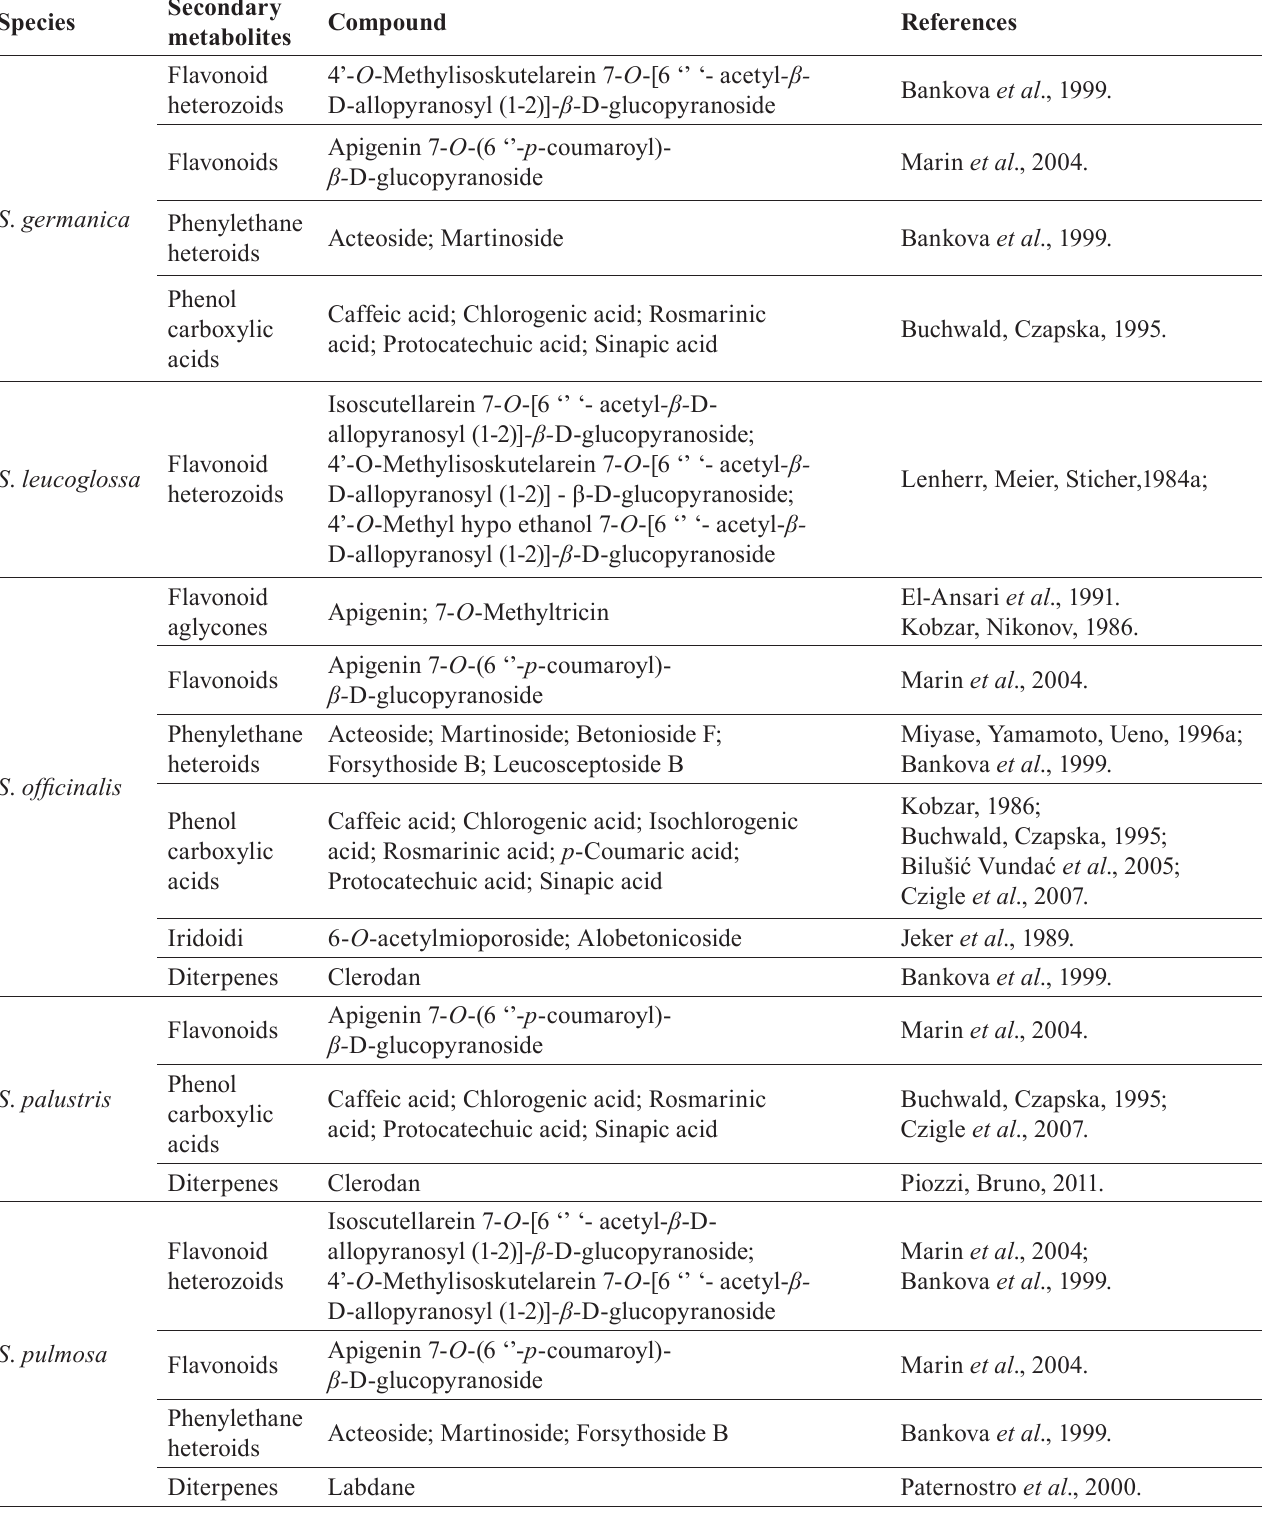
TABLE I - S econdary metabolites of Stachys